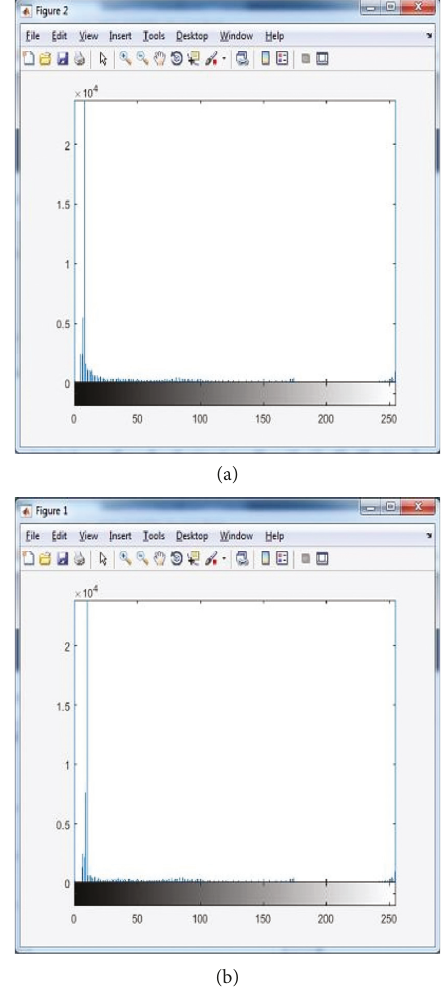
Figure 3: Histograms of (a) original message and (b) extracted message.